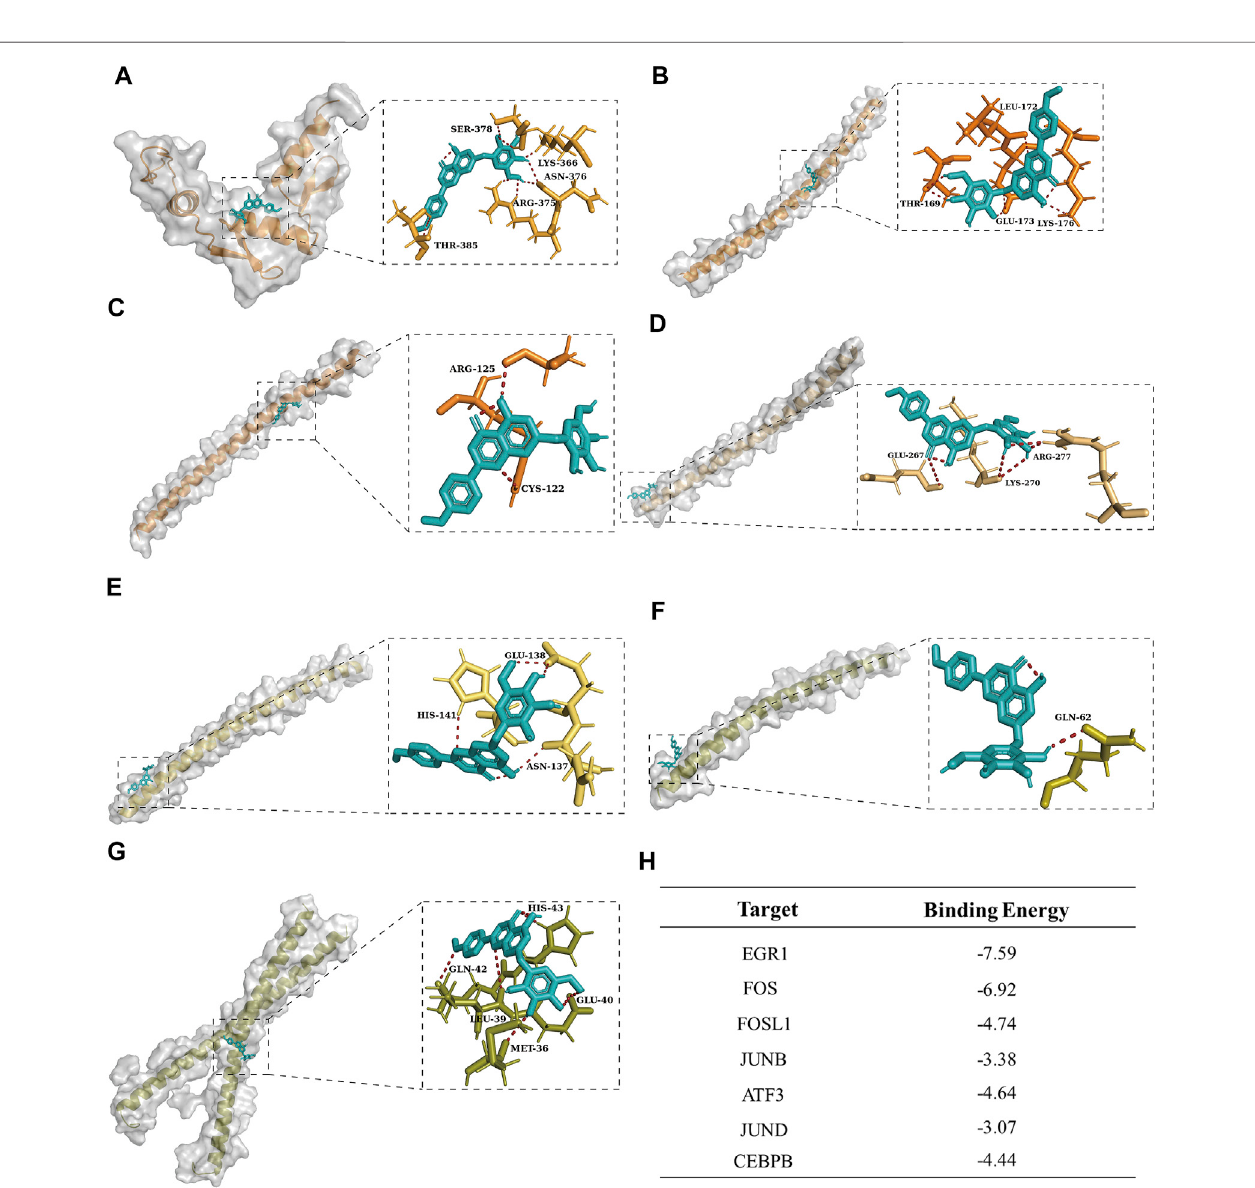
FIGURE 6 | Molecular docking visualization results between tilianin and corresponding targets. Tilianin (ligand) was bound to the surface of seven hub genes (receptor) with amino acid residues of receptors. Tilianin was shown as the red stick structure, and the receptors were painted in different colors. Hydrogen bonds are shown as dotted lines, as indicated. (A) EGR1-tilianin, (B) FOS-tilianin, (C) FOSL1-tilianin, (D) JUNB-tilianin, (E) ATF3-tilianin, (F) JUND-tilianin, and (G) CEBPB-tilianin. (H) Binding energy between tilianin and